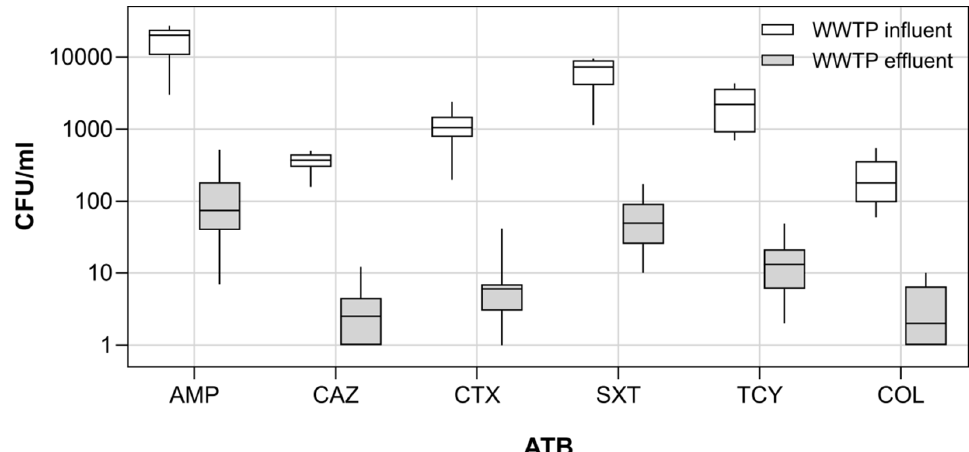
Figure 5. Box plots of the abundance of culturable Escherichia coli resistant to ampicillin (AMP), ceftazidime (CAZ), cefotaxime (CTX), sulfamethoxazole (SXT), tetracycline (TCY) and colistin (COL) measured in the wastewater entering WWTP and treated effluents from WWTP.